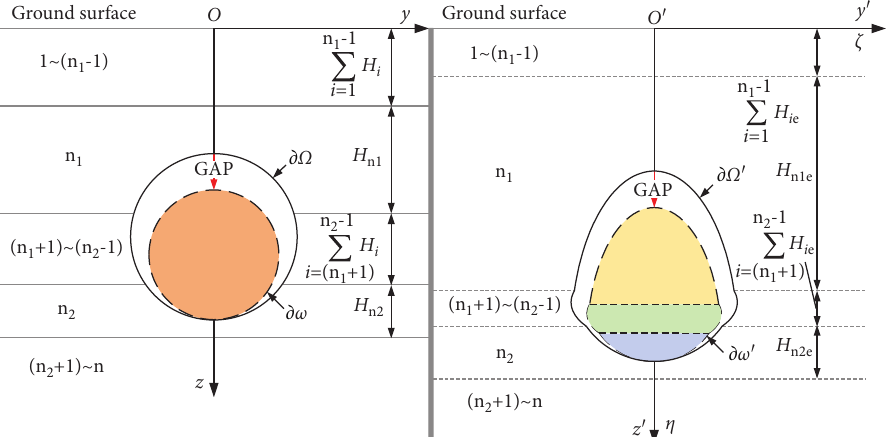
Figure 2: Transformation of the boundary of excavation z Ω and the boundary after convergence z ω from the multilayered soil system into the single layer soil system